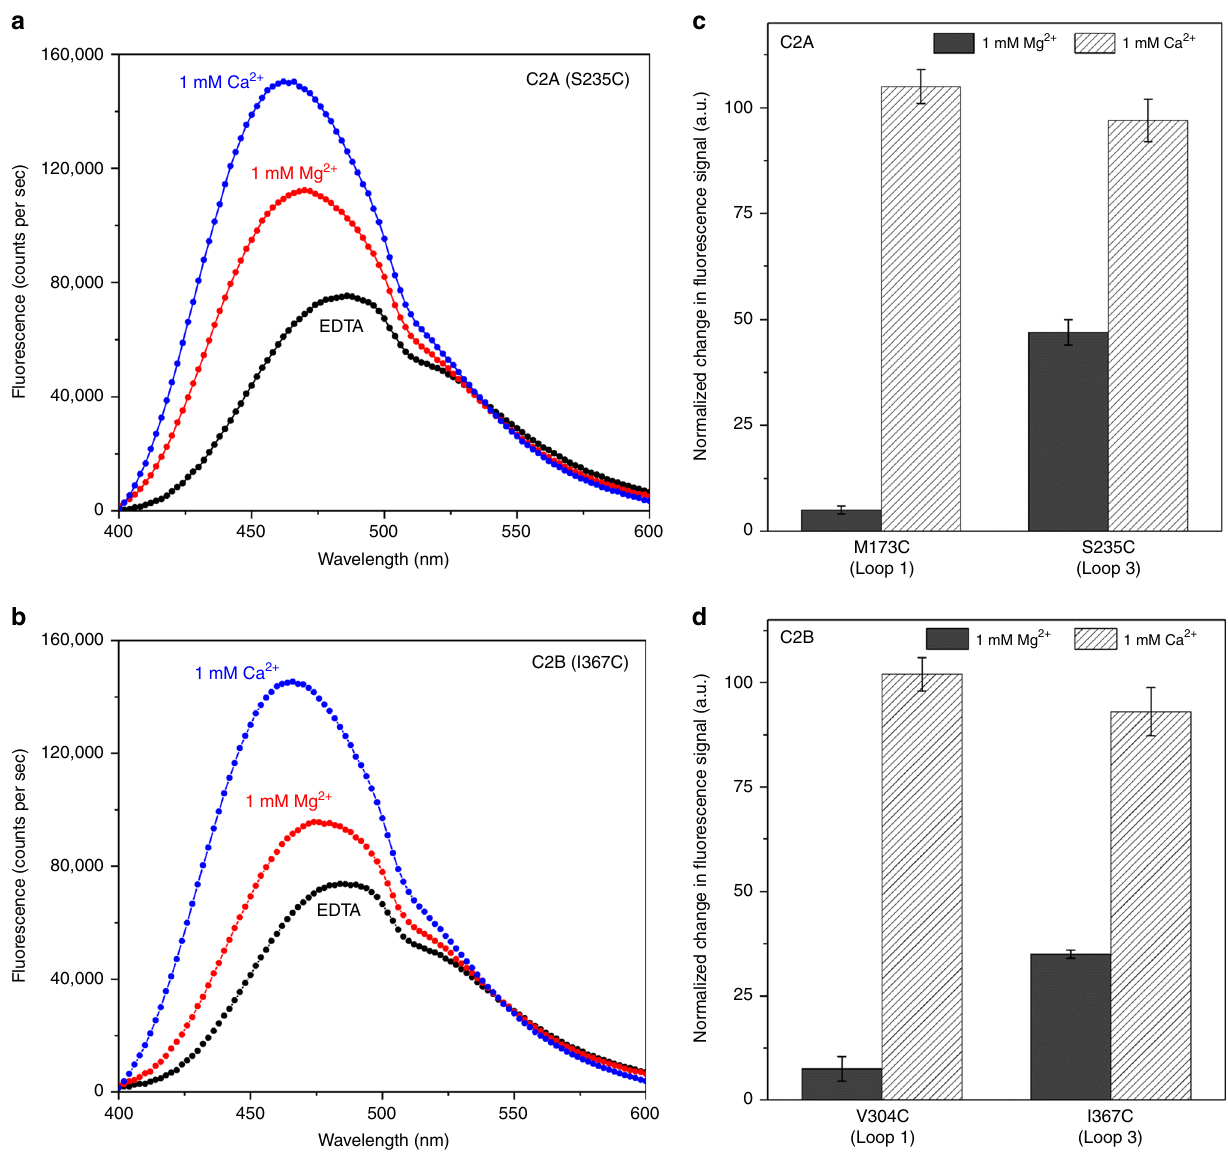
Fig. 4 Mg 2 + induces the partial insertion of loop 3 on both C2 domains. a , b Fluorescence analysis using environmentally-sensitive probe, IAEDANS introduced at the tip of the aliphatic loops of the C2 domains shows the Mg 2 + (red curve) induces an insertion of loop 3 (residue S235 of C2A & residue I367 of C2B) as evidenced by an increase in the fl uorescence intensity and blue-shift in the emission maxima as compared to an EDTA control (black curve). This Mg 2 + -induced membrane interaction is distinct, with shallower positioning of the aliphatic loops in the lipid membrane as compared to the Ca 2 + -bound state (blue curve) ( c , d ) Normalized fl uorescence signal at the emission maxima shows that Ca 2 + -induces deep insertion of both loop 1 (residue M173 in C2A and V304 in C2B) and loop 3, but Mg 2 + speci fi cally triggers partial insertion of loop 3 alone in both C2 domains. Representative fl uorescence curves are shown, along with averages and standard deviations from 4 to 5 independent